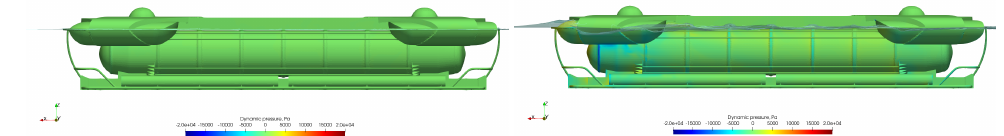
Figure 14. Pressure distribution and free surface geometry at 1.5 and 6 knots for Geometry 3 sailing at the free surface.